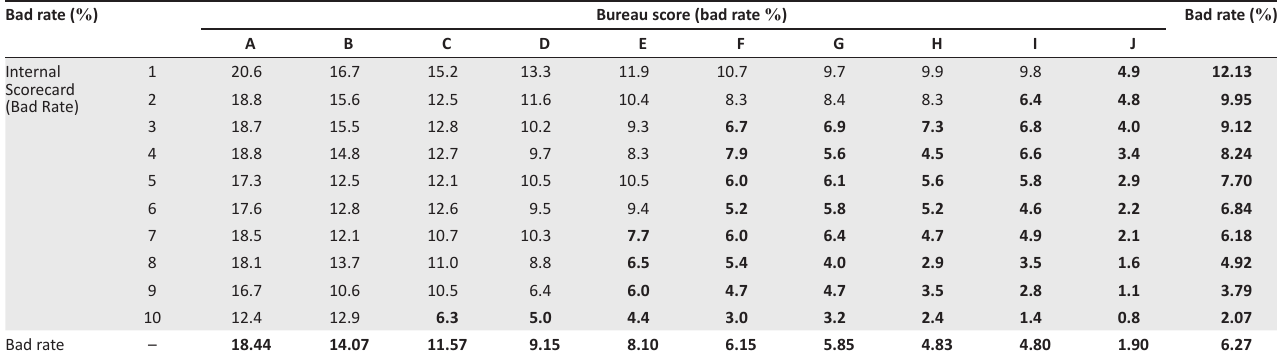
TABLE 11: Two-dimensional Credit Scoring Matrix Model. Bad rate ( % ) Bureau score (bad rate % ) Bad rate ( %